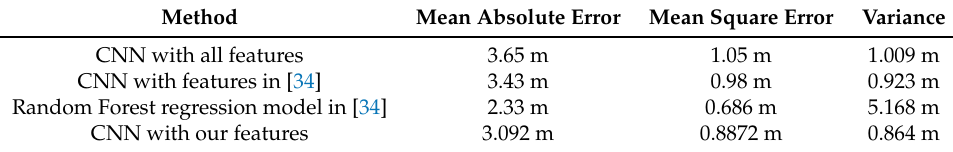
Table 3. Result comparison table for the four test